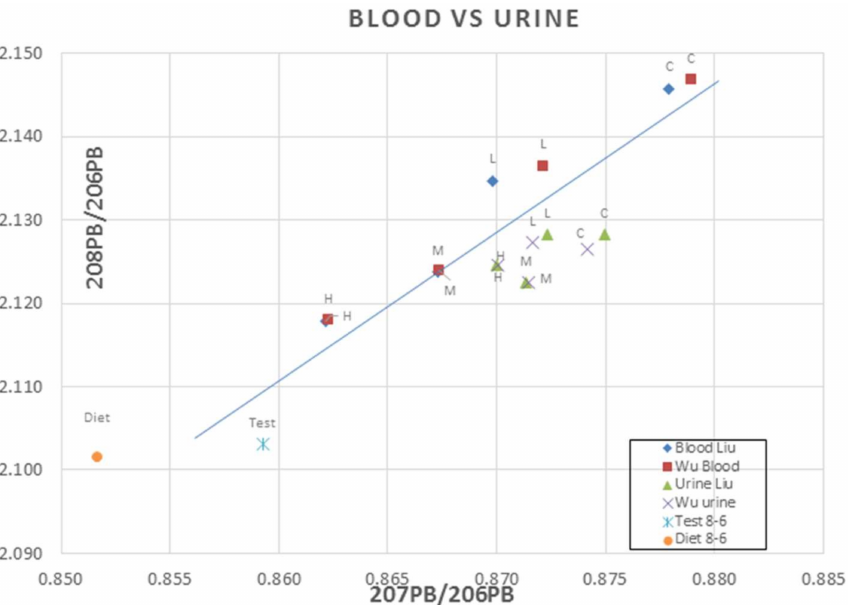
Figure 11. A comparison of 207 Pb/ 206 Pb and 208 Pb/ 206 Pb ratios in blood and urine from the two investigations. C denotes control, L low dose, M medium dose and H high